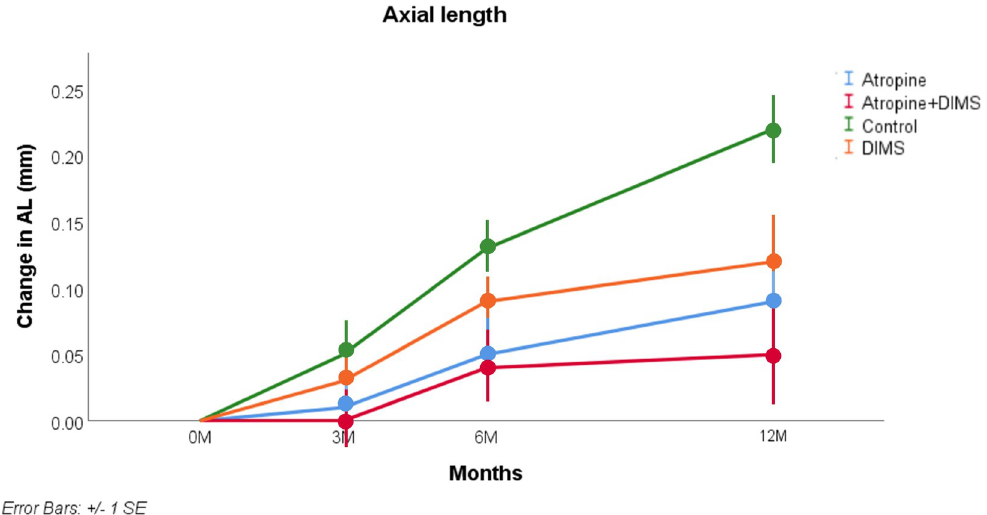
Fig 2. Model-adjusted mean and SE of change in axial length from baseline to 12 months.